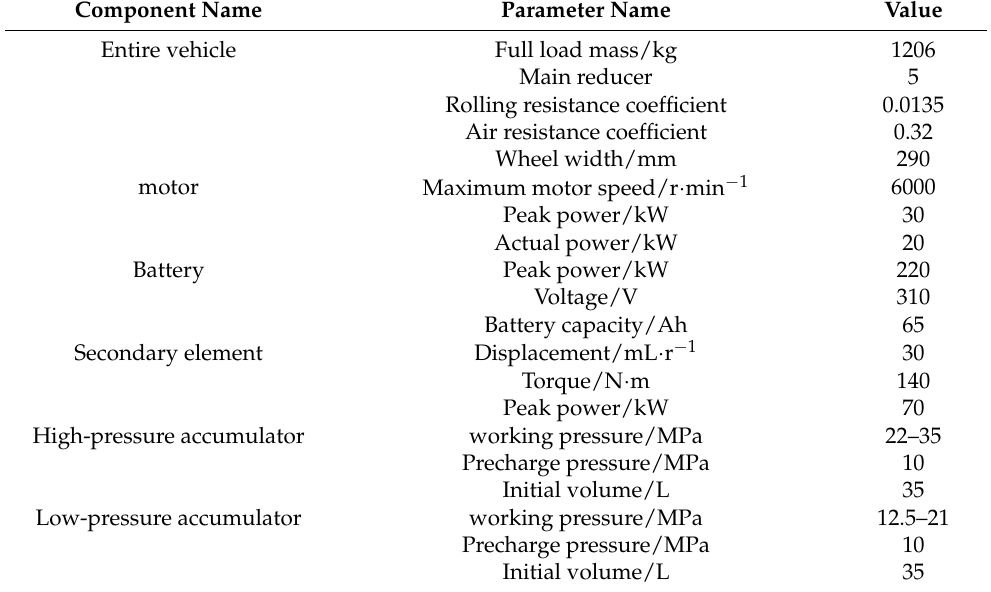
Table 2. Basic parameters of the entire